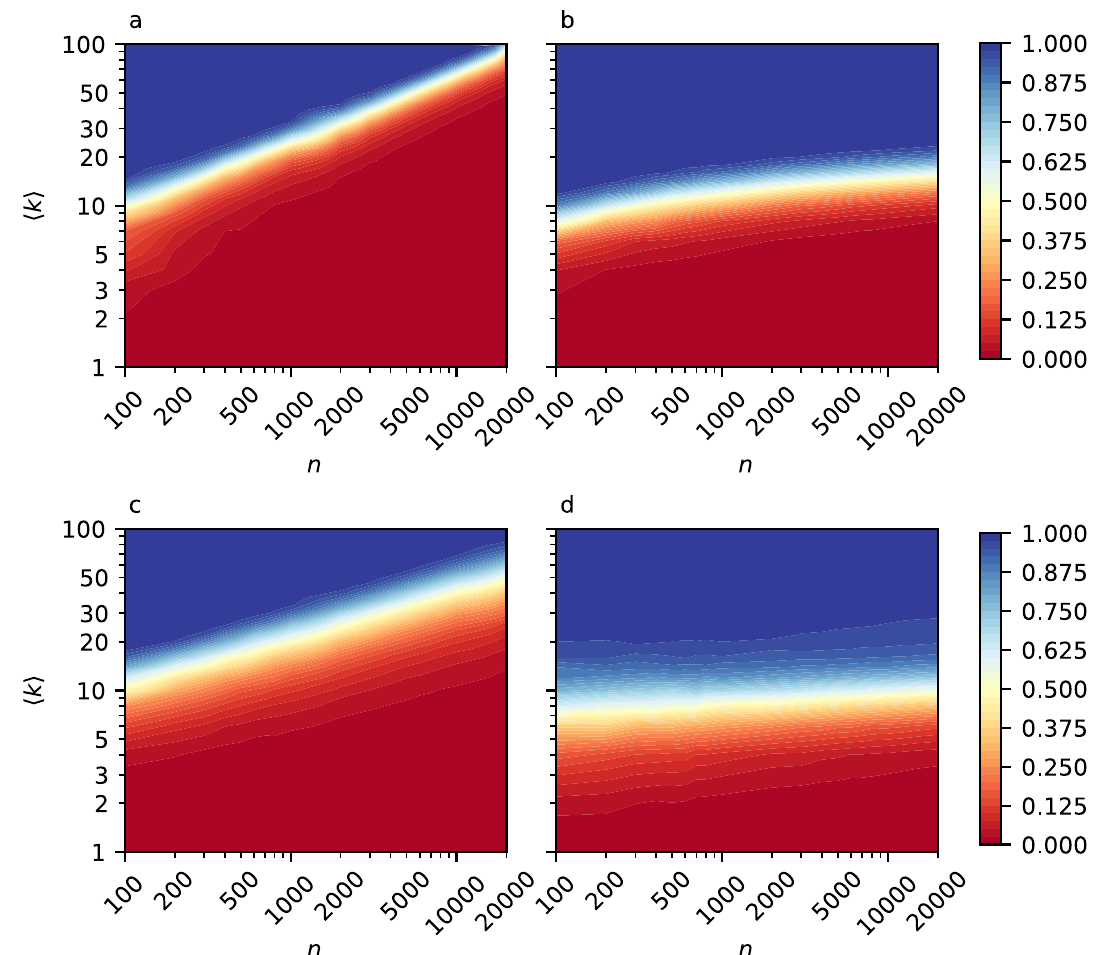
Figure 2. Uniqueness maps: heatmaps representing the variation of the uniqueness of neighborhoods value (in color: the blue area corresponds to a uniqueness value equal to 1, while the red area corresponds to a uniqueness value equal to 0) in networks generated according to ( a ) ER model, ( b ) WS model with probability of rewiring β = 0.5 , ( c ) the BA model, and ( d ) the RGG model, as the function of the average degree (cid:31) k (cid:30) (on the vertical axis) and network size n (on the horizontal axis). The axis are in logarithmic scale. The uniqueness values are computed as the mean of 10 independently simulated networks for each average degree and network size value. 100